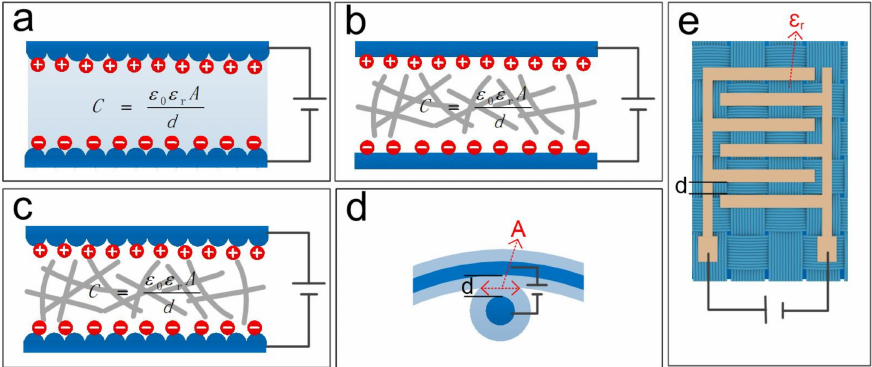
Figure 3. Capacitive pressure sensors based on different functional textile layers: ( a ) Textile-structured electrodes; ( b ) Textile-structured dielectric layers; ( c ) All-textile structures; ( d ) Yarn structures; ( e ) In- plane